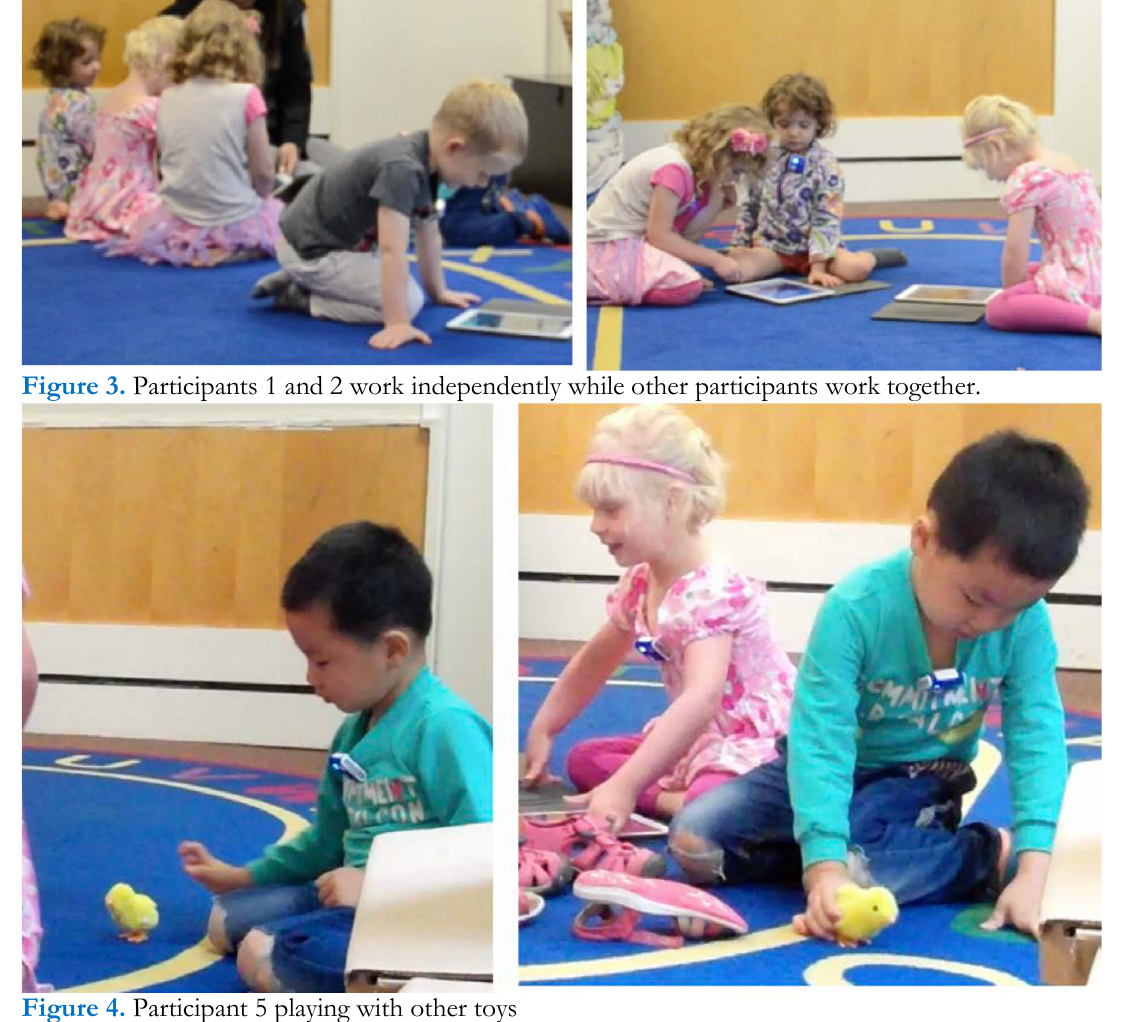
Figure 4. Participant 5 playing with other